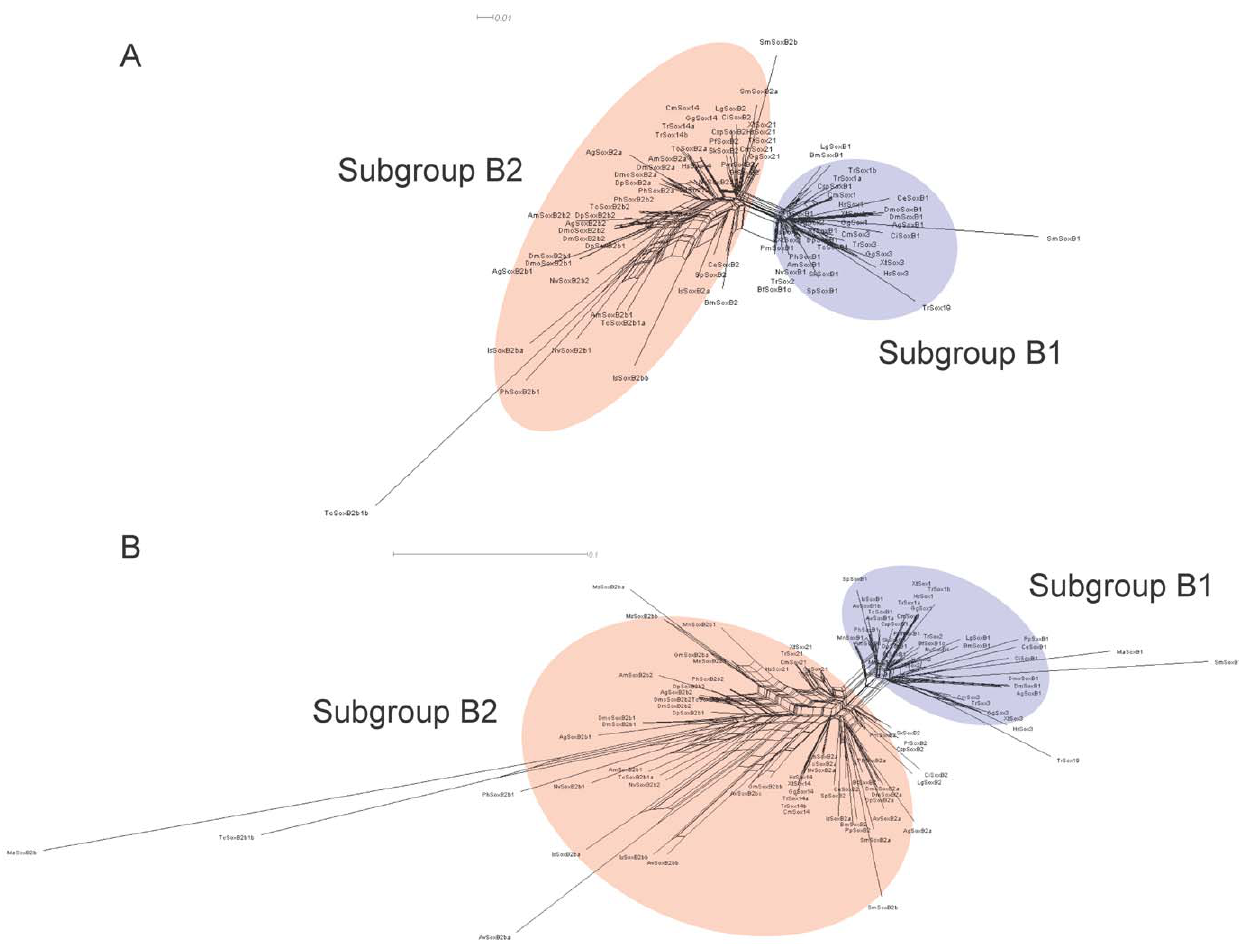
Figure 5. Split networks of the bilaterian SoxB1/B2 proteins based on the HMG domain alignment. (A) Split network based on the alignment in Fig. 2 under the JTT model. (B) Split network based on the alignments in Figs. 2 and S2B under the JTT model. Abbreviations of species names are as in Table 1.